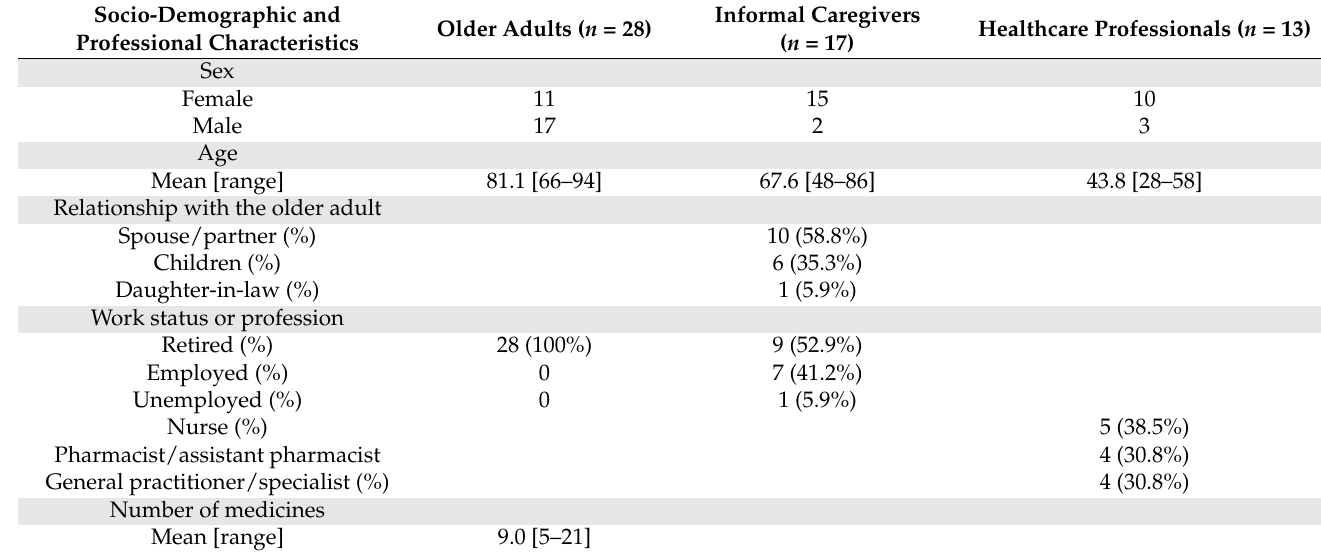
Table 2. Participants’ socio-demographic and professional